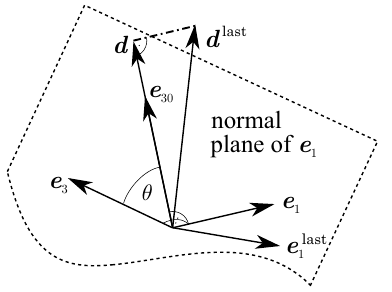
Figure 4. In large deformation problems it is crucial to prevent the director d from becoming collinear with the beam axis direction e 1 . Therefore a director update in form of a projection into the normal plane of e 1 is suggested at every time or load step of the simulation. Note, that an update of this kind does not change the configuration of the local frame, see also Eq. (6) and Fig.